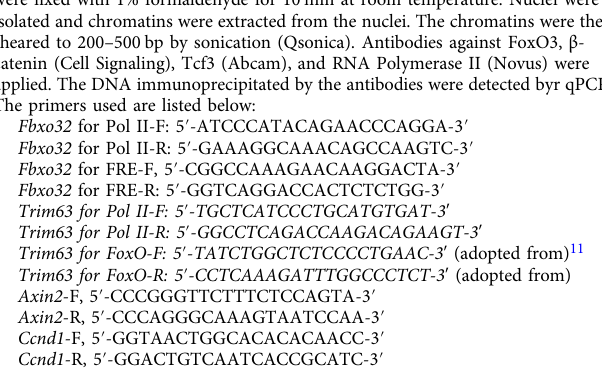
Fbxo32 for FRE-R: 5 ′ -GGTCAGGACCACTCTCTGG-3 ′ Trim63 for Pol II-F: 5 ′ -TGCTCATCCCTGCATGTGAT - 3 ′ Trim63 for Pol II-R: 5 ′ - GGCCTCAGACCAAGACAGAAGT-3 ′ Trim63 for FoxO-F: 5 ′ - TATCTGGCTCTCCCCTGAAC-3 ′ (adopted from) 11 Trim63 for FoxO-R: 5 ′ -CCTCAAAGATTTGGCCCTCT-3 ′ (adopted from) Axin2 -F, 5 ′ -CCCGGGTTCTTTCTCCAGTA-3 ′ Axin2 -R, 5 ′ -CCCAGGGCAAAGTAATCCAA-3 ′ Ccnd1 -F, 5 ′ -GGTAACTGGCACACACAACC-3